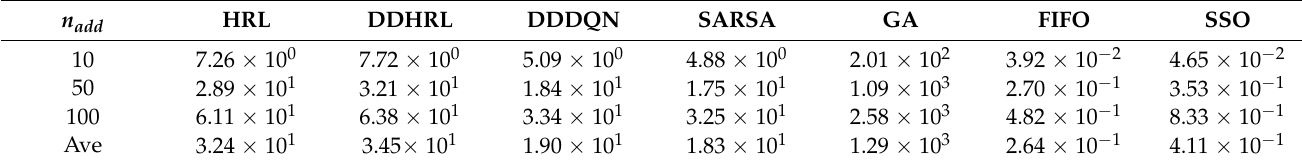
Table 5. CPU times (s) for comparative methods and their average